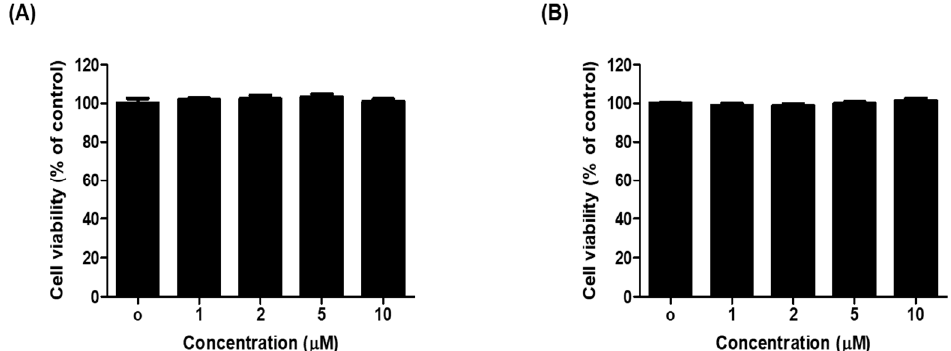
Figure 4. The effect of compound 1c on cell viability of B16F10 melanoma cells. Cells were treated with various concentrations of 1c for 24 h ( A ) and 48 h ( B ), and then examined by EZ-cytox assay. Data are representative of three separate experiments. Bars indicate standard errors of means (SEM).